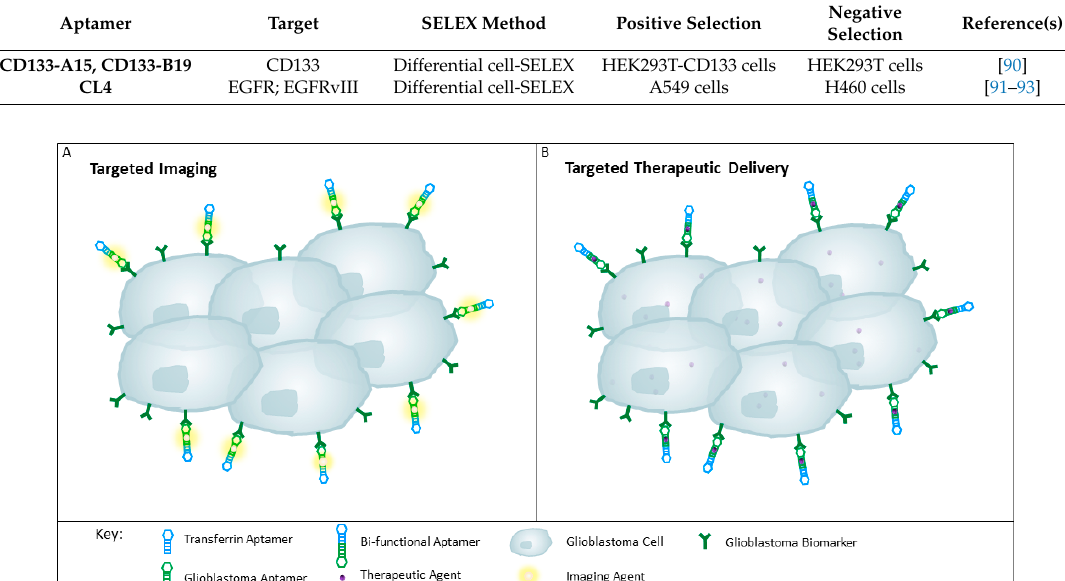
Table 2. Aptamers generated against potential biomarkers for glioblastoma targeting.